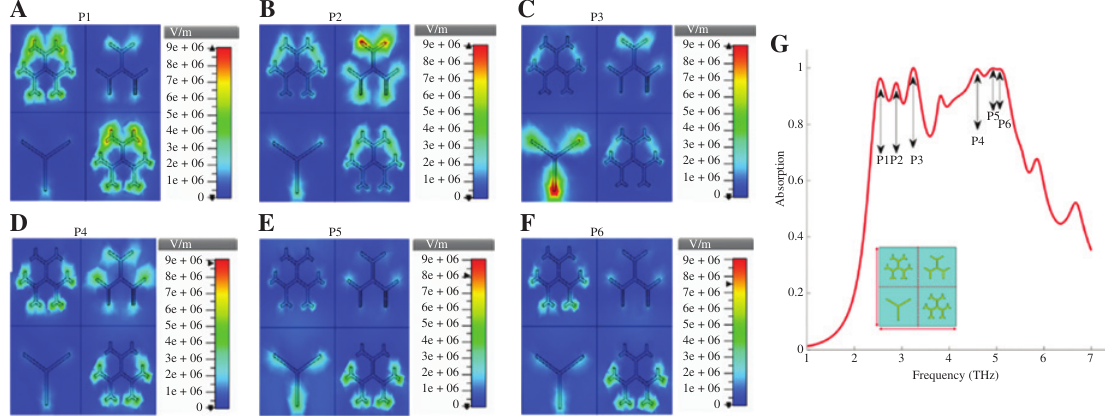
Figure 8: Numerically simulated E-field profiles for broadband peaks. (A–F), Two-dimensional E- field profiles for six different peaks of a broadband supercell design at normal incident wave. (G) Simulated broadband absorption spectrum showing the six distinct peaks. Inset: supercell